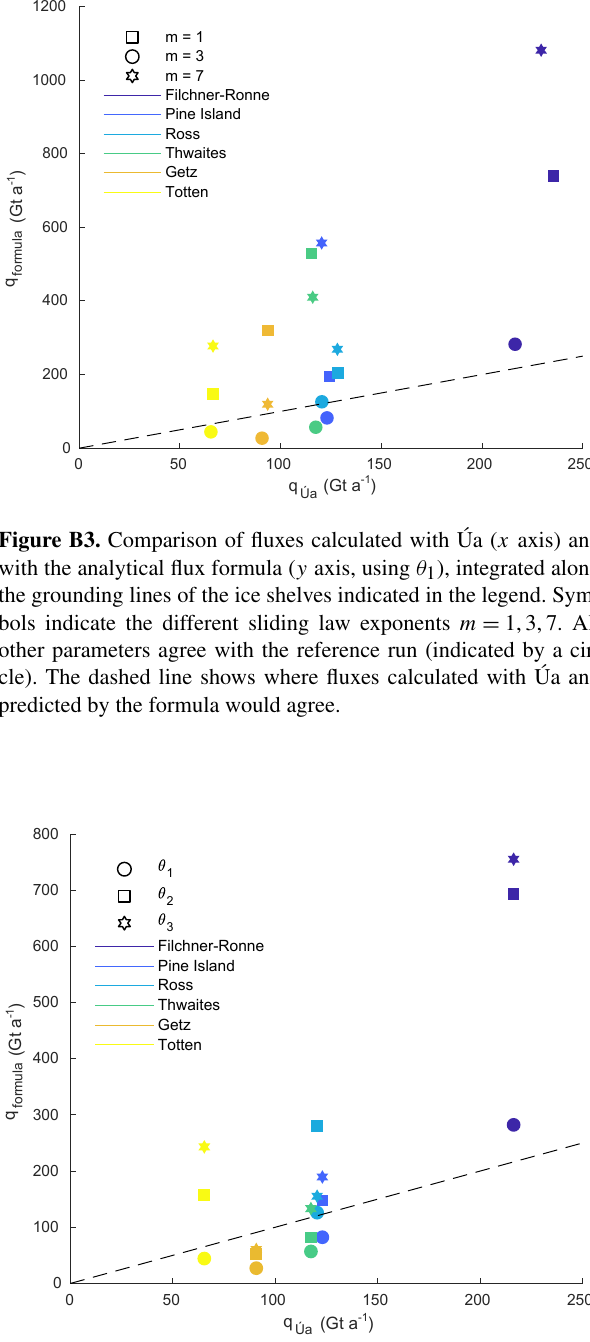
Figure B4. Comparison of fluxes calculated with Úa ( x axis) and with the analytical flux formula ( y axis), integrated along the grounding lines of the ice shelves indicated in the legend. Symbols indicate the different definitions of θ as described in Sect. 3. All other parameters agree with the reference run (indicated by a cir- cle). The dashed line shows where fluxes calculated with Úa and predicted by the formula would agree.